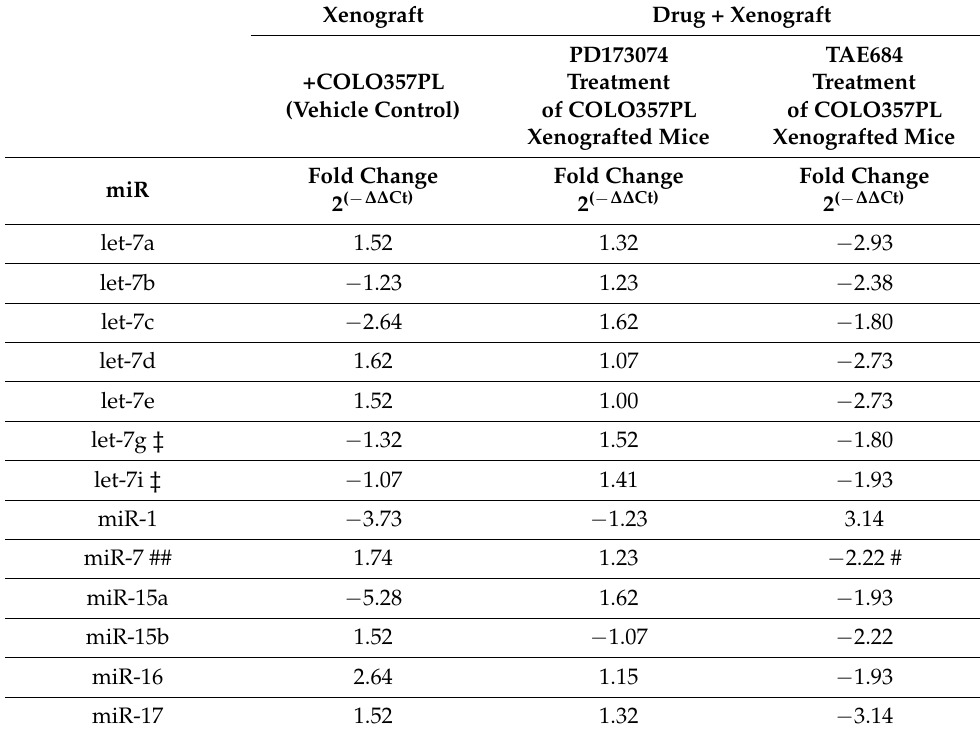
Table 2. Serum miRs related to the presence of COLO357PL xenograft tumors, and serum miRs related to short-term treatment with the FGFR inhibitor PD173074 or the ALK inhibitor TAE684. The expression levels of 352 serum miRs in a COLO357PL xenograft mouse model were analyzed by qPCR and normalized for respective median Ct value. miRs with Ct < 30 in at least one comparison are